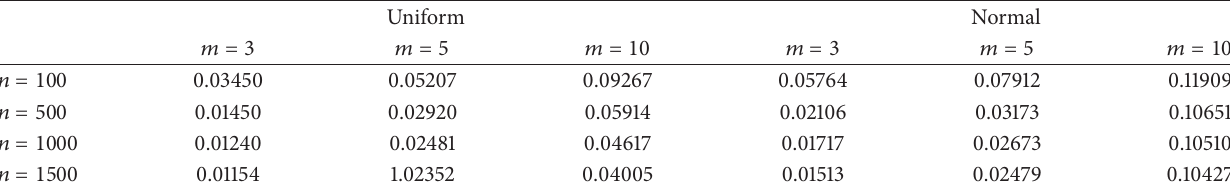
Table 2: Convergence results of the SPTA-A